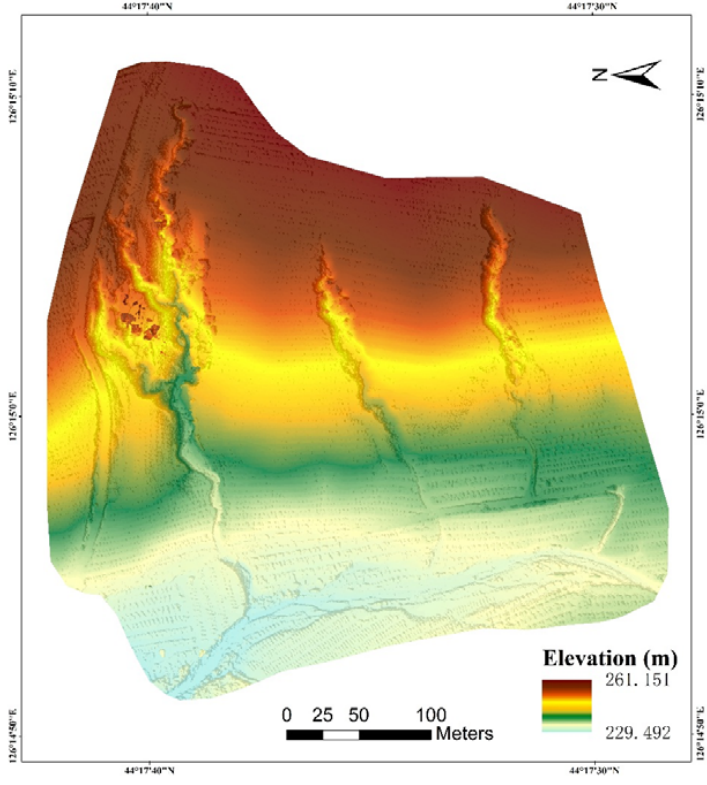
Figure 4. Digital Surface Model (DSM) of the small study site. It was applied by hill ‐ shading.